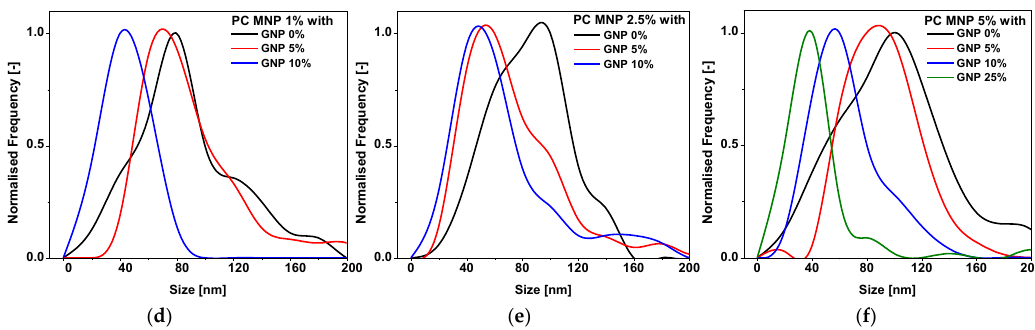
Figure 14. ( a ) Transmission (S 12 ) (Here to help observe the resonance property as the DC magnetic field applied, S 12 is taken as a difference between S 12 at the applied DC magnetic field (1 KOe–9 KOe) and S 12 at 0 Oe) measured for thin film containing GNPs and MNPs, as a function of applied DC magnetic field in range 0–9 kOe; all columns contain the same magnetic weight percentage and all rows contain the same GNPs amount ( b ) TEM images of PC with 2.5% MNPs (left) and 2.5%MNPs+10%GNPs (right) ( c ) measurements of saturation magnetization obtained with a MPMS-XL5 SQUID magnetometer (Quantum Design, U.S.A.) ( d – f ) size distribution of MNP for 1%, 2.5% and 5% at different concentration of GNPs respectively.